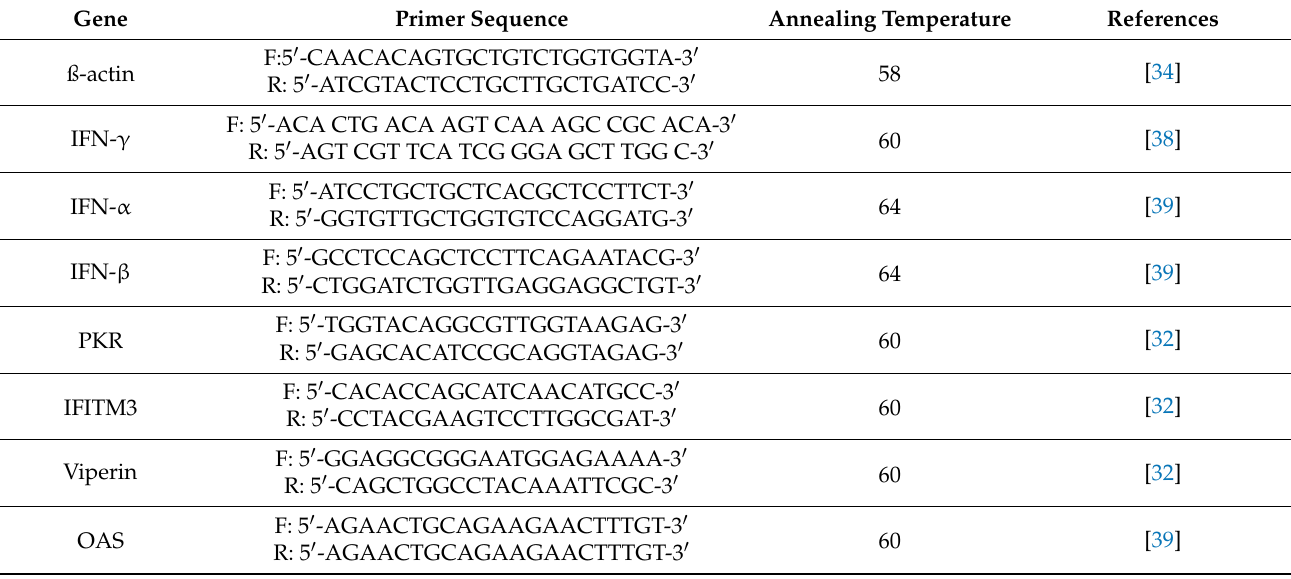
Table 1. Primer sequences used for quantitative real-time polymerase chain reaction. Gene Primer